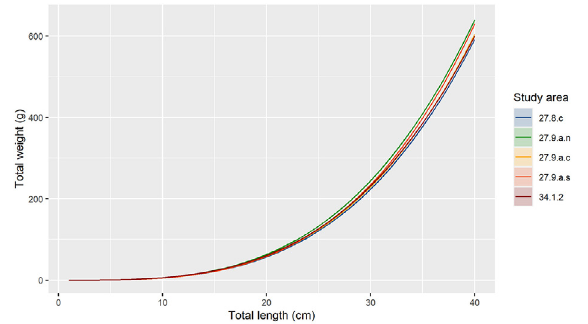
Fig. 3. – Plot of the modelled relationship between the total length (cm) and the total weight (g) by study area. Geographical study areas from south to north are 34.1.2, Canary Islands; 27.9.a.s, Gulf of Cadiz; 27.9.a.c, W Portuguese coast; 27.9.a.n, NW Spanish coast; 27.8.c., Cantabrian Sea. Shadow area, 95% confidence intervals.